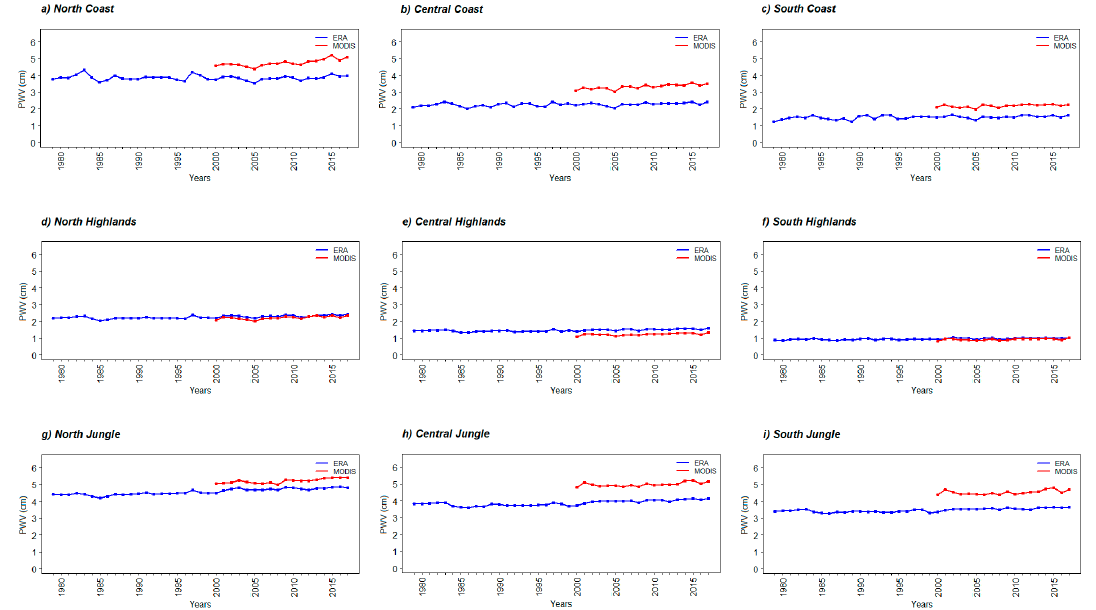
Figure 7. Multiannual variation of the PWV using MODIS and ERA-Interim datasets: ( a – c ) for the Coast region, ( d – f ) for the Highlands region, and ( g – i ) for the Jungle region.